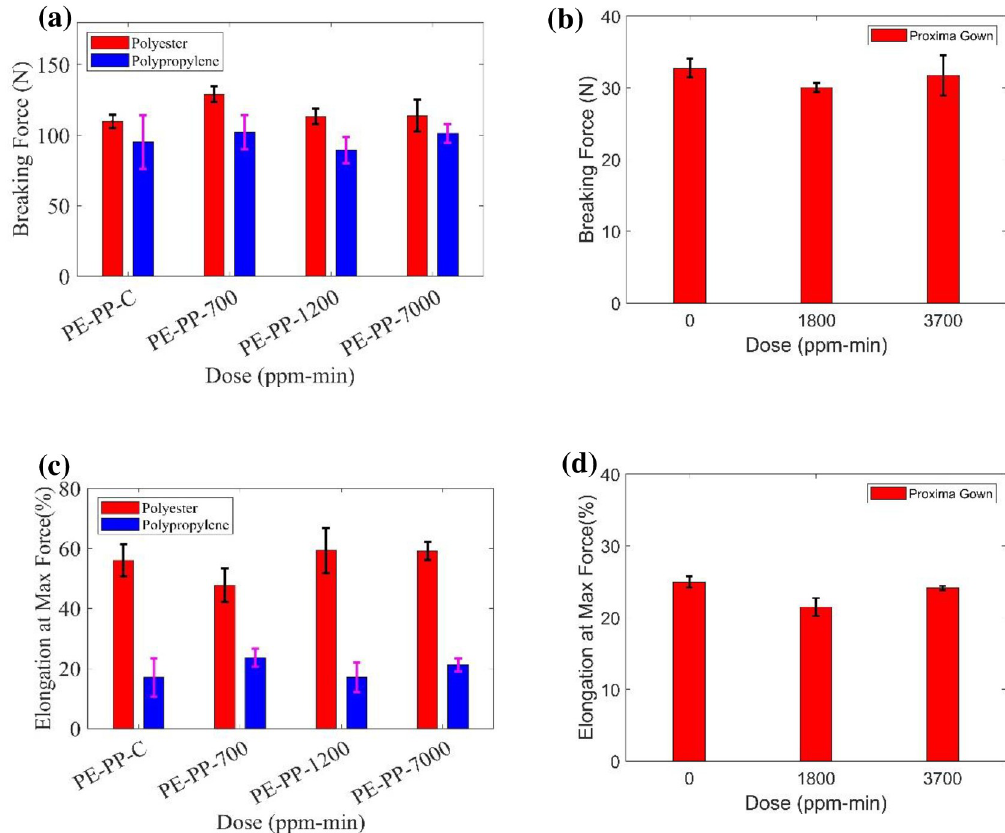
Fig 13. Measured breaking force of treated (a) polyester and polypropylene materials and (b) Proxima gown. Measured elongation at max force of treated (c) polyester and polypropylene materials and (d) Proxima